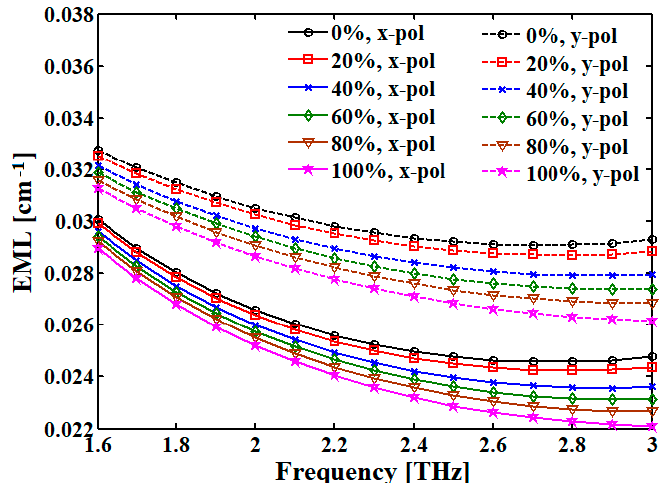
Figure 11. Effective material loss (EML) of the proposed sensor at L = 280 µm as a function of frequency.